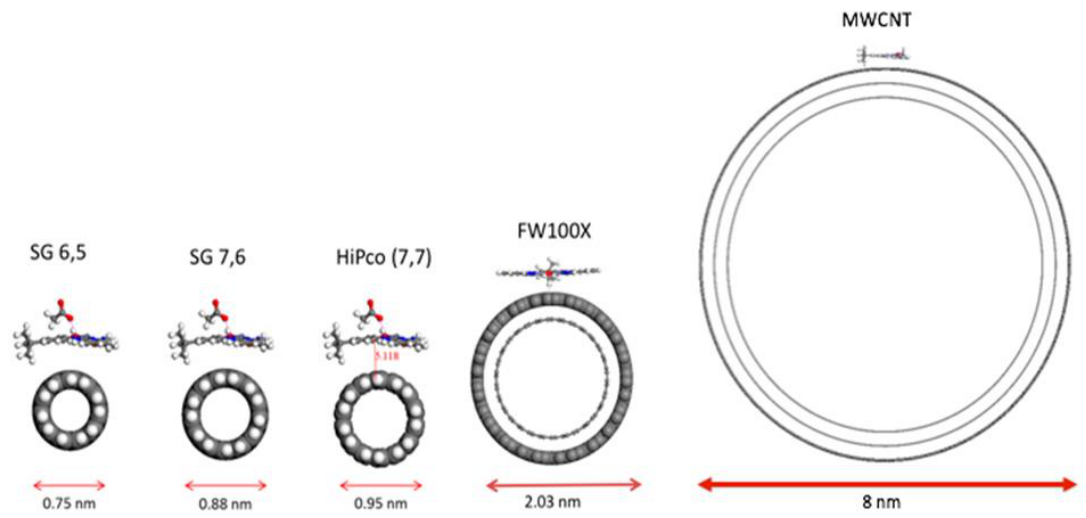
Figure 2. + 2Zn2 complex (upper left) adsorbed to various chirality and sized Figure 2 . +2Zn2 complex (upper left) adsorbed to various chirality and sized CNTs .